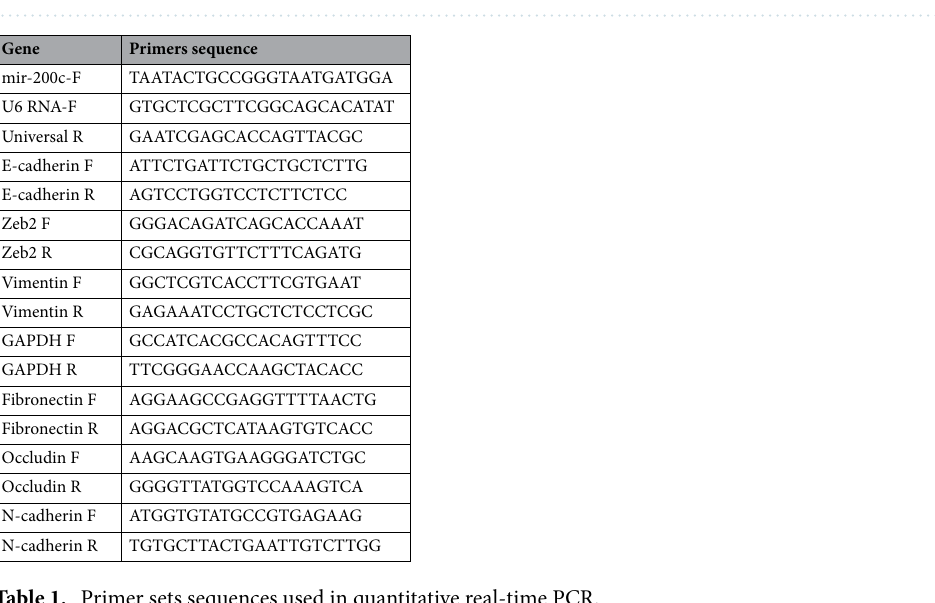
Figure 1. Invert and fluorescent microscope images of GFP transfection efficiency of GFP gene expression in ( a ) YM1 and ( b ) KYSE-30 cells. Fluorescent microscopy images of GFP control cells 24 h after transfection.